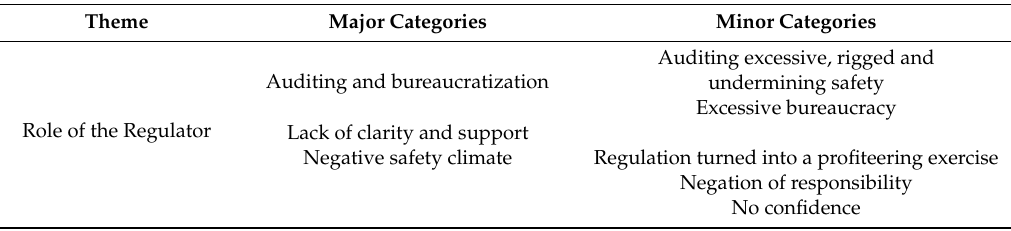
Table 4. Summary of findings for the Role of the Regulator